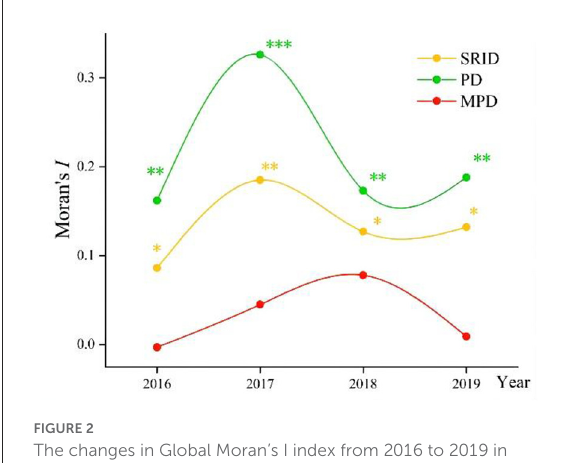
FIGURE2 The changes in Global Moran’s I index from 2016 to 2019 in China (allocated by population). * p < 0.05; ** p < 0.01; *** p < 0.001.